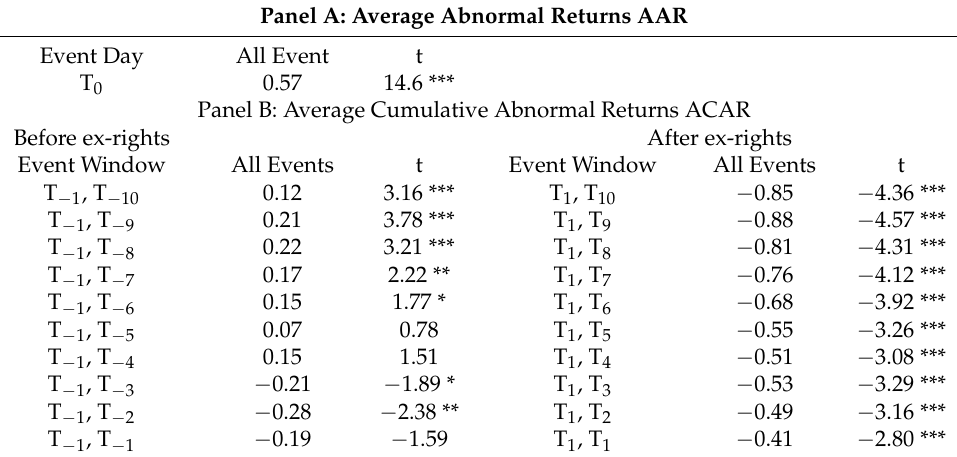
Table 1. Average abnormal returns and average cumulative abnormal